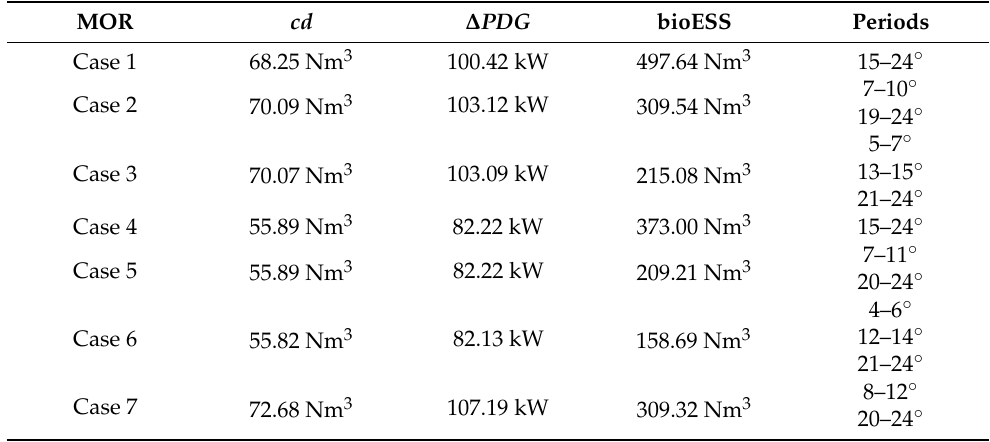
Table 3. Results of the studied operating